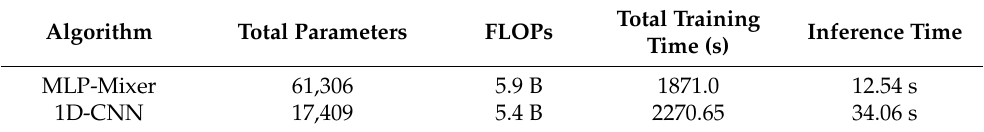
Table 1. Main characteristics of the MLP-Mixer and 1D-CNN lifetime processor.